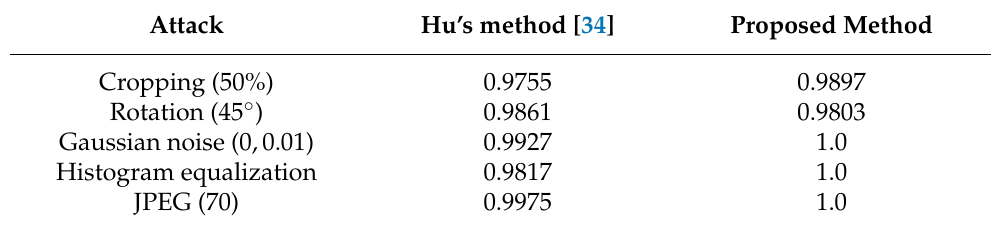
Table A1. Robustness comparison between Hu’s method [34] and the proposed scheme in terms of NC.